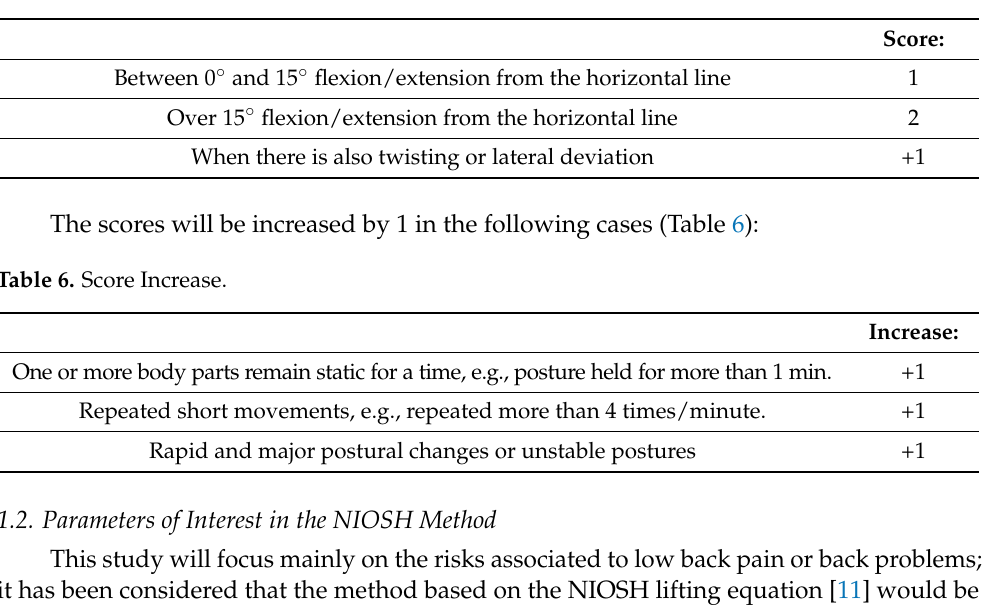
Table 5. Wrist angles.